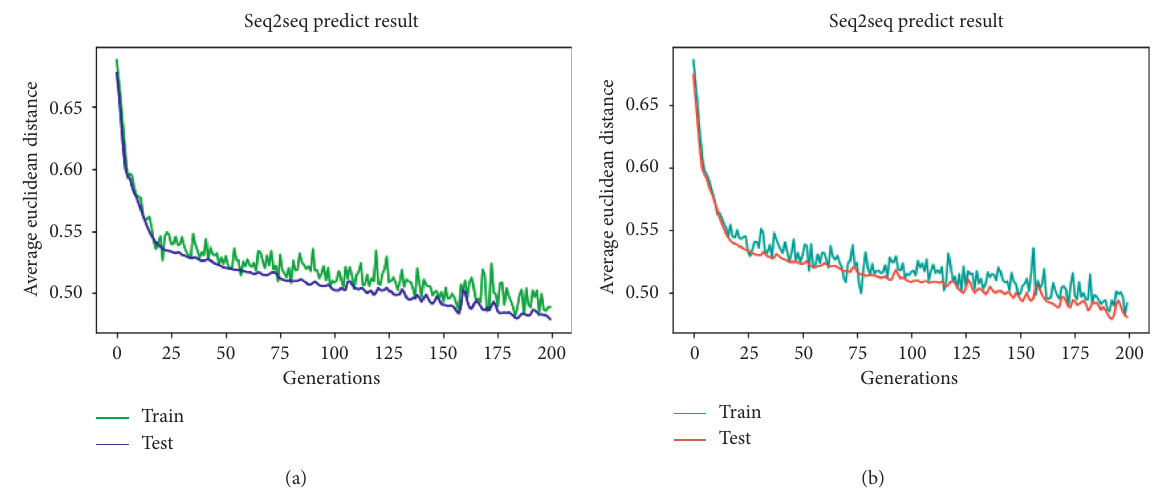
Figure 12: The average deviation for once (a) and twice (b) shrunk time window.